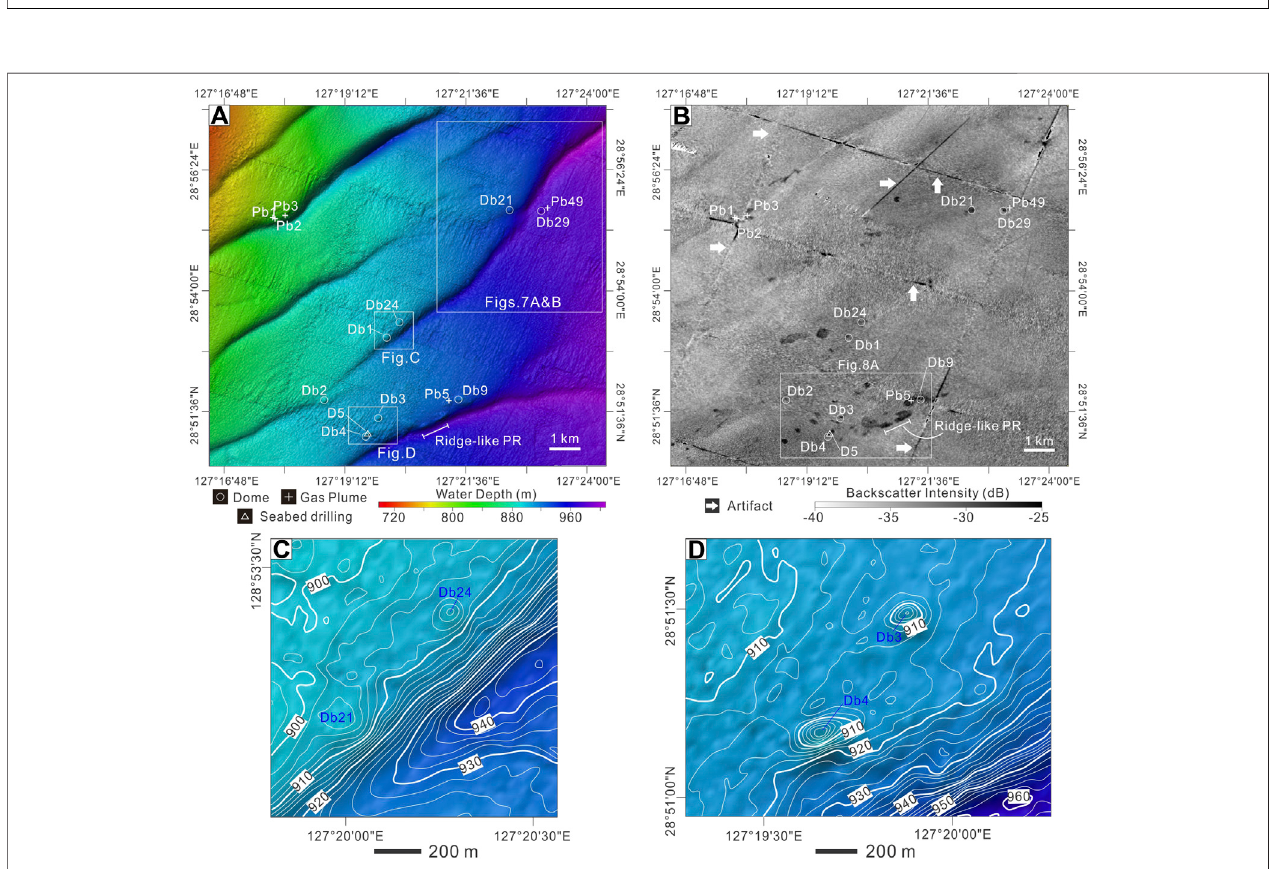
FIGURE 5 | (A) Bathymetric map showing the locations of the features associated with gas emission. All of the curvilinear features at the seabed have been con fi rmedtobethefaultscarps(Lietal.,2021).PR – positivereliefinthisandthesubsequent fi gures. (B) Themapofthebackscatteringintensityattheleveloftheseabed. Please note the anomalous backscattering intensities occur not only surrounding the domed seabed but also at the relatively fl at places. The white arrows mark the artifacts along the nadir lines. (C , D) The bathymetric maps near some examples of the positive reliefs (Db24, 21, 3 and 4). The contour interval is 2 m.